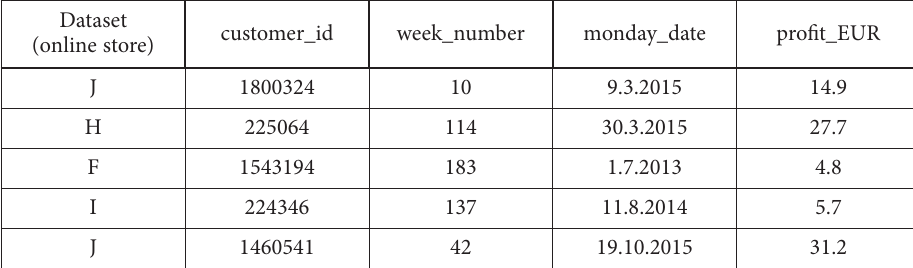
Table 1. Five randomly selected rows from the complete dataset Dataset (online